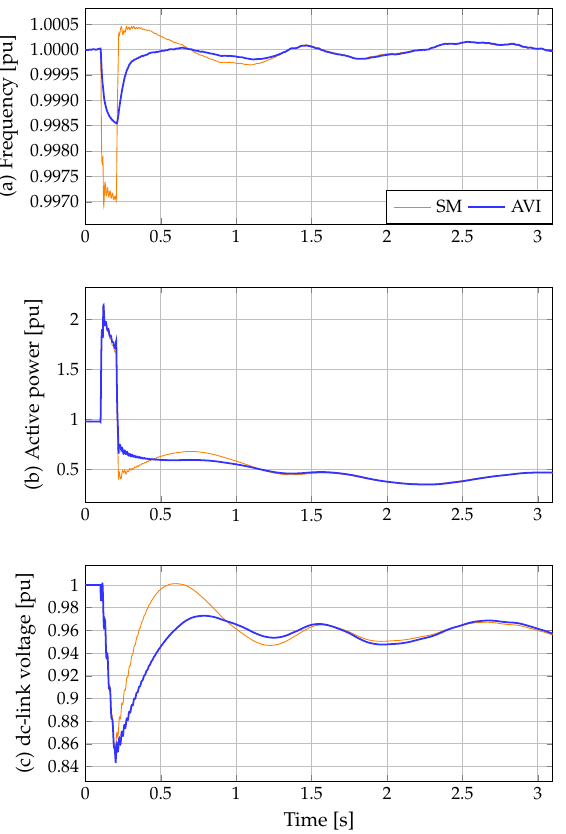
Figure 7. Dynamic responses for the case 2: (a) frequency, (b) active power, and (c) dc-link voltage